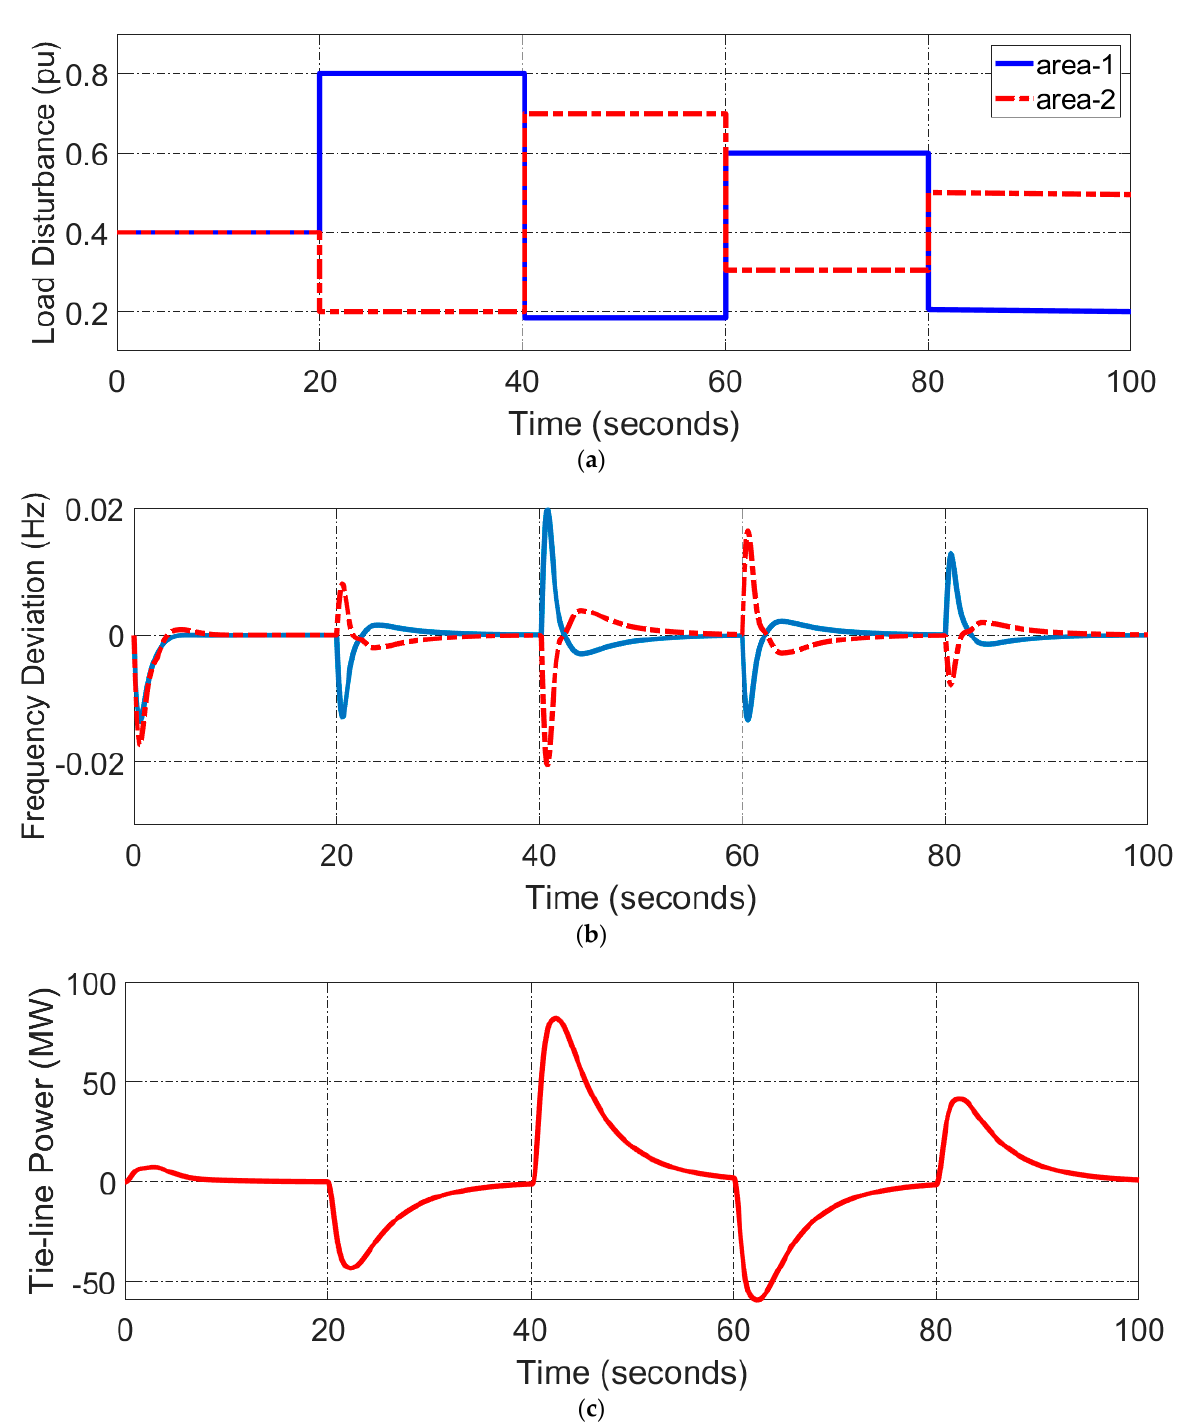
Figure 22. The response of optimal ANN for: ( a ) load disturbance, ( b ) frequency deviation, ( c ) tie line power.